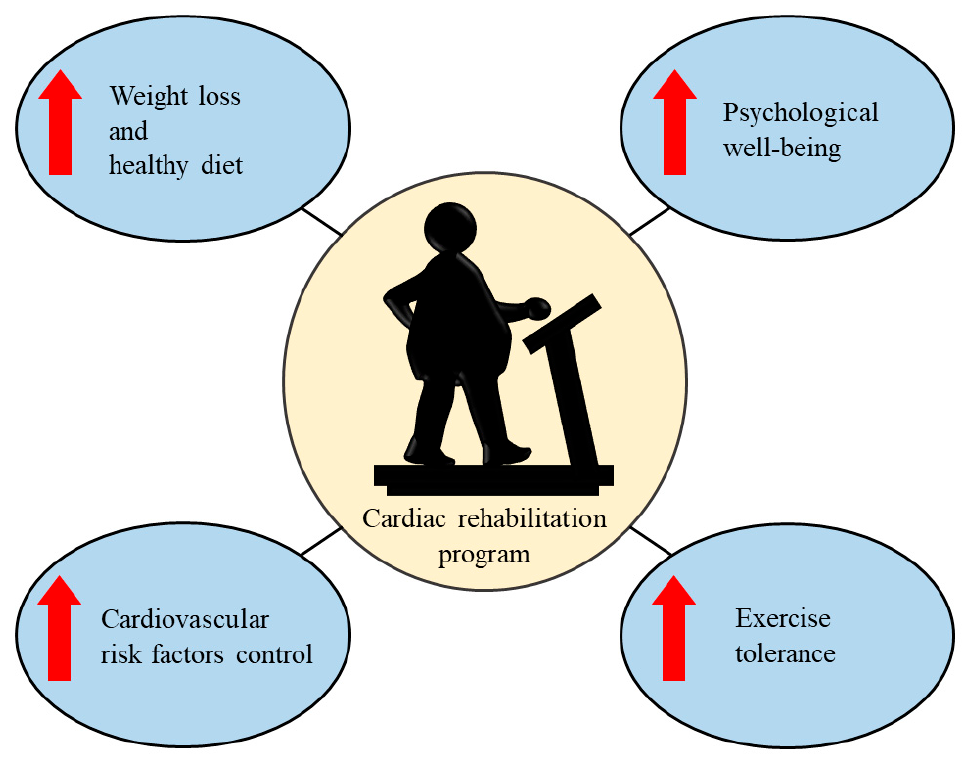
Figure 3. Beneficial effects of cardiac rehabilitation in patients with obesity.